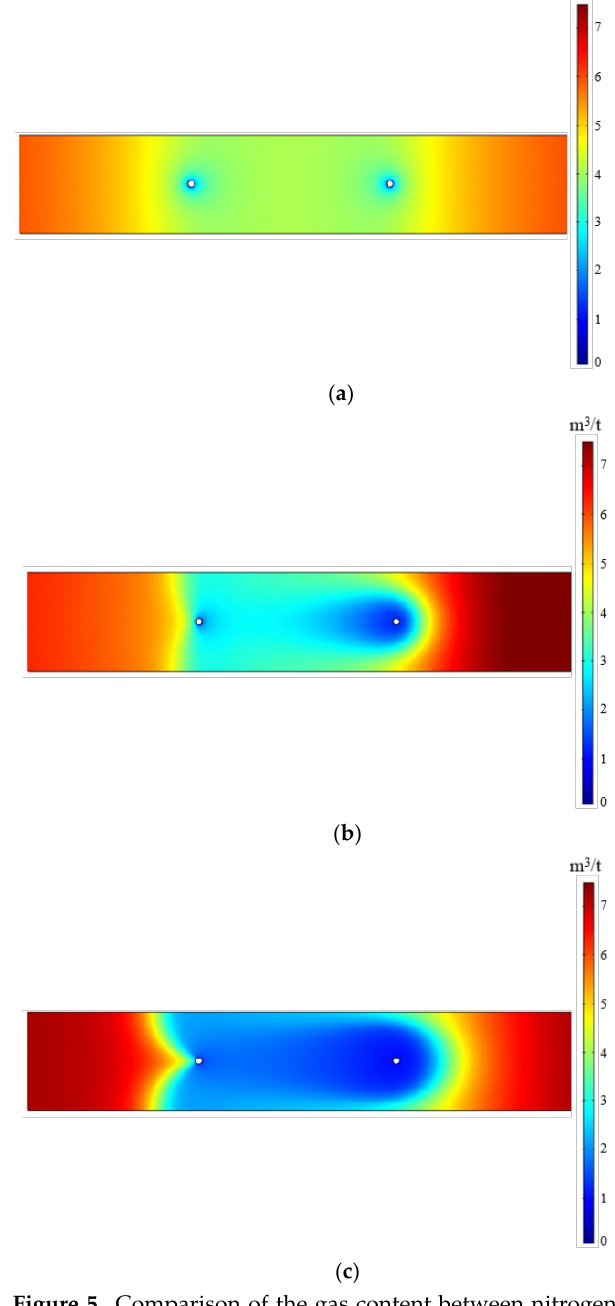
Figure 5. Comparison of the gas content between nitrogen injection and conventional drainage: ( a ) Conventional boreholes drainage (2 months), ( b ) Nitrogen injection drainage (0.5 MPa, 2 months), ( c ) Nitrogen injection drainage (1.0 MPa, 2 months).